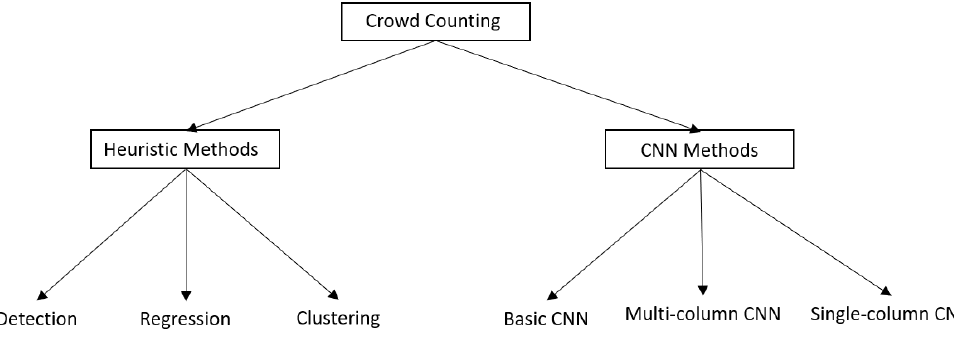
Figure 1. Overall structure of the current review